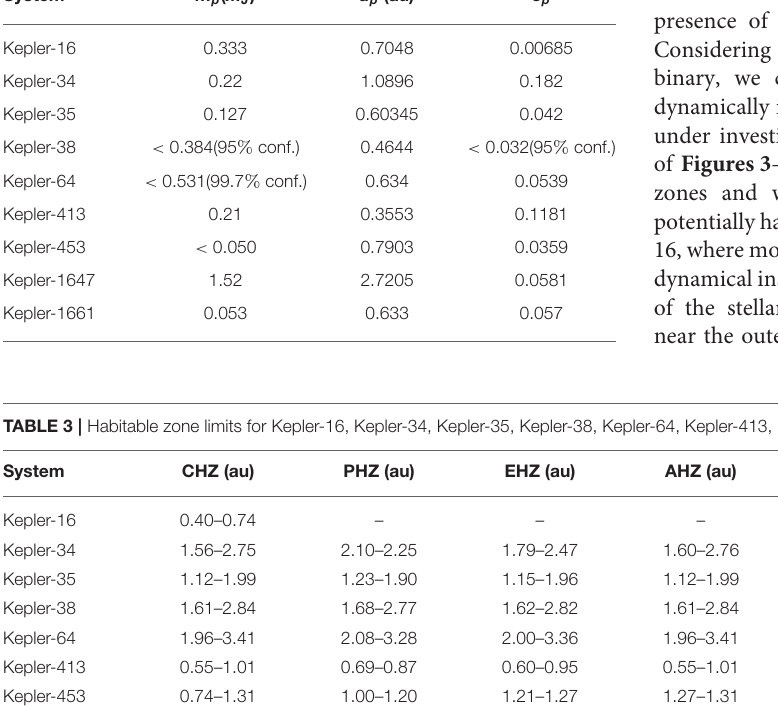
TABLE 2 | Mean mass, semi-major axis, and eccentricity for Kepler-16b, Kepler-34b, Kepler-35b, Kepler-38b, Kepler-64b, Kepler-413b, Kepler-453b, Kepler-1647b, and Kepler-1661b. The uncertainties can be found in the corresponding references in section 3. System